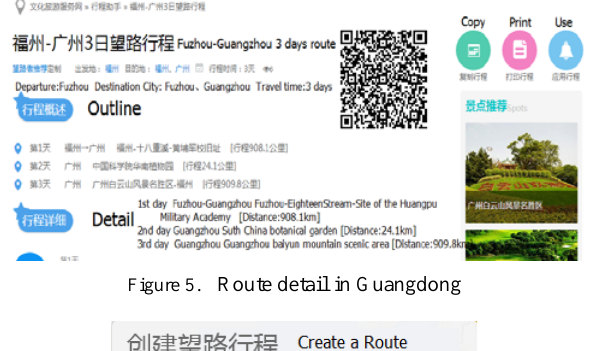
Figure 5. Route detail in Guangdong